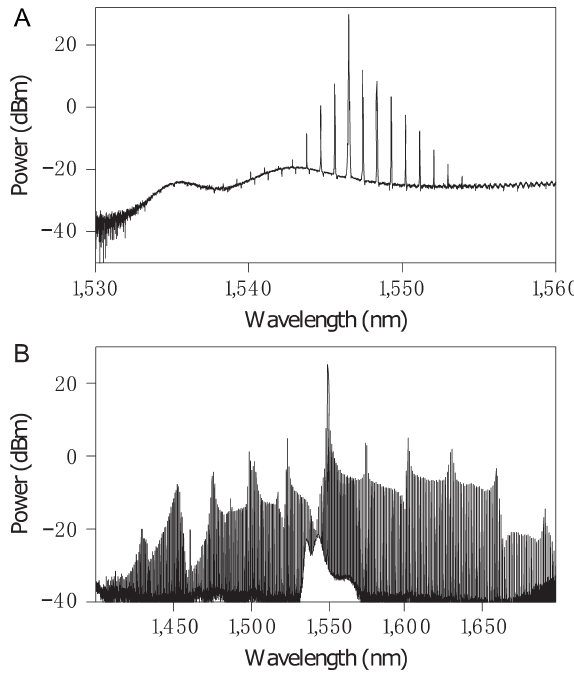
Figure 11: (A) Type-I and (B) type-II combs generated from a silicon nitride microring with radius 200 µm. The comb line spacing is ~115 GHz. Adapted by permission from Macmillan Publishers Ltd: Nature Photonics [31], copyright